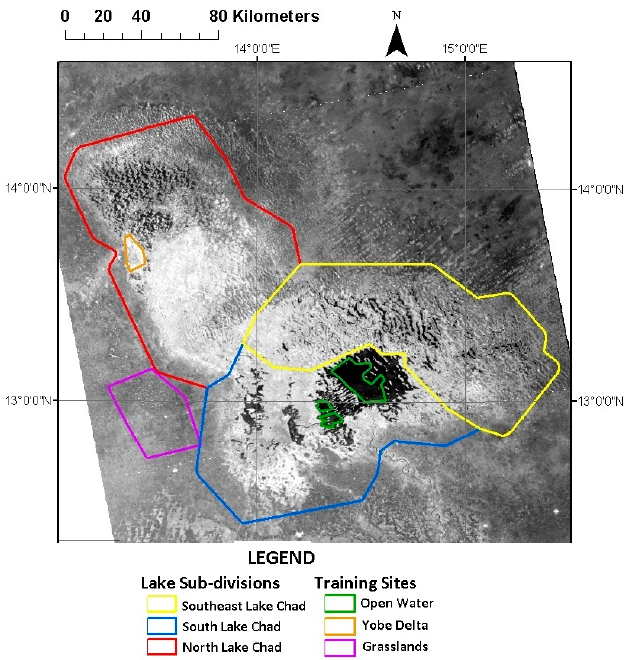
Figure 3. Lake sub-divisions and training sites identified in this study. The background image is from ESA Sentinel-1a C-band radar (9 April 2015).